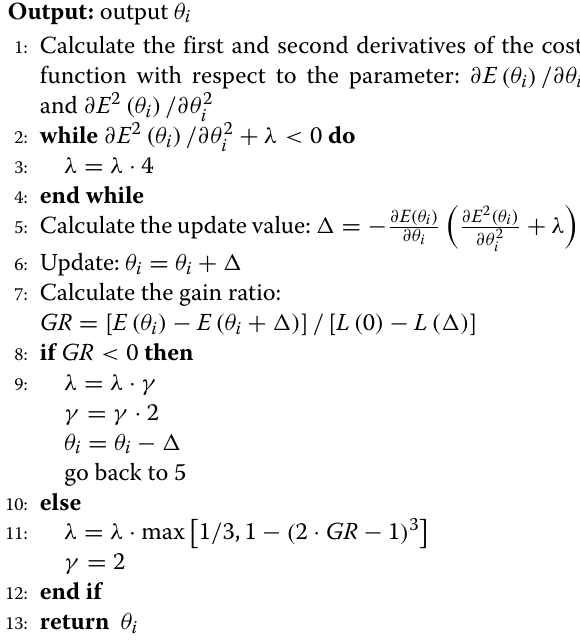
Algorithm 1 Levenberg-Marquardt